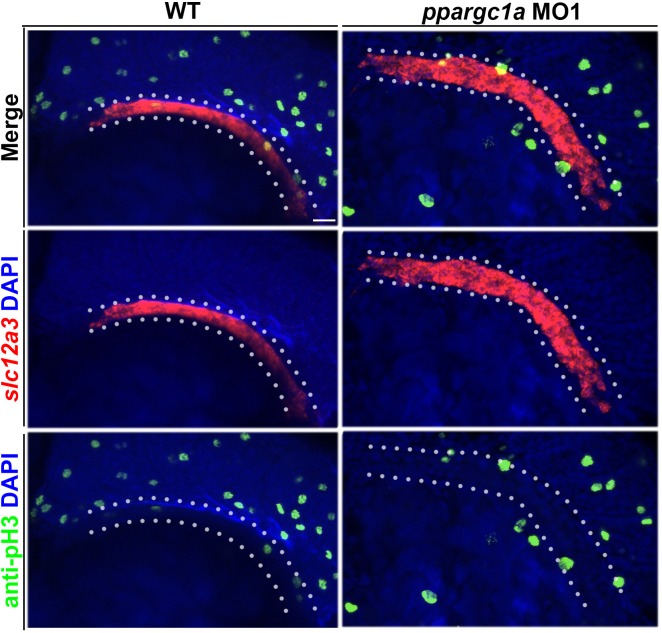
Confocal image split channels of slc12a3 and anti-pH3 in WT and ppargc1a-deficient 20 ss zebrafish.slc12a3 (red) with DAPI (blue) on bottom, anti-pH3 (green) with DAPI (blue) middle, and merge on top. Scale bar = 30 μm.